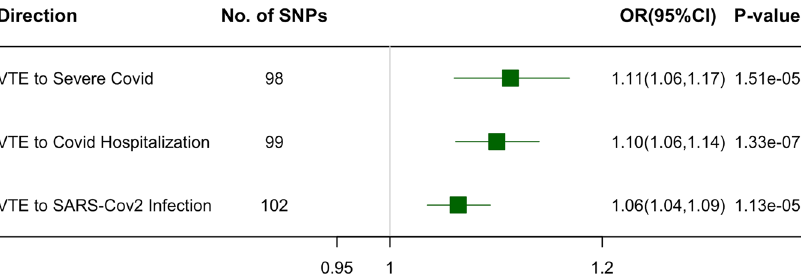
Fig. 5 Mendelian randomization analysis on the association of genetically predicted VTE with the risk of COVID-19-related traits using inverse variance weighting (IVW). The estimates are presented as odds ratios (OR) with 95% con fi dence intervals (CI). The presented data are available in Supplementary Data